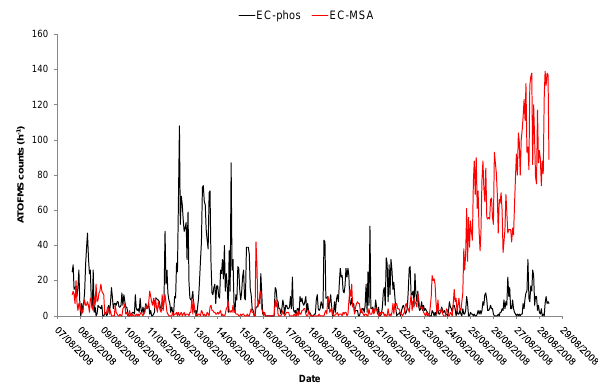
Fig. 14. Hourly integrated particle counts for EC-phos and EC- MSA particles for 7–28 August